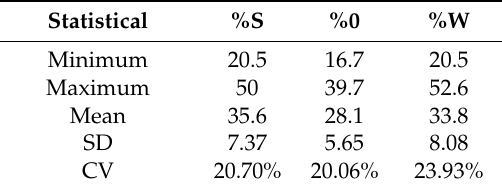
Table 2. Descriptive statistics of the variables.